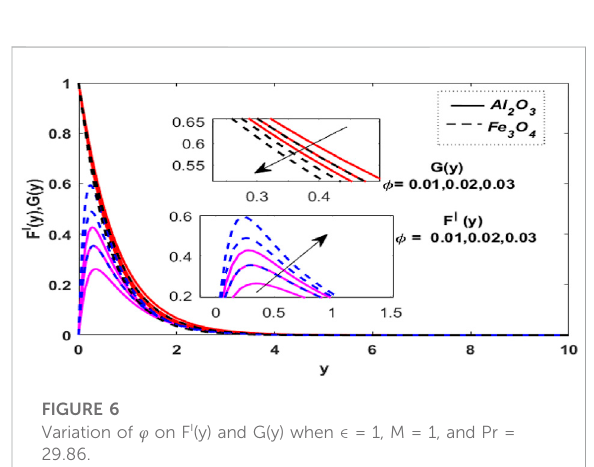
FIGURE 6 Variation of φ on F I (y) and G(y) when ∈ = 1, M = 1, and Pr = 29.86.